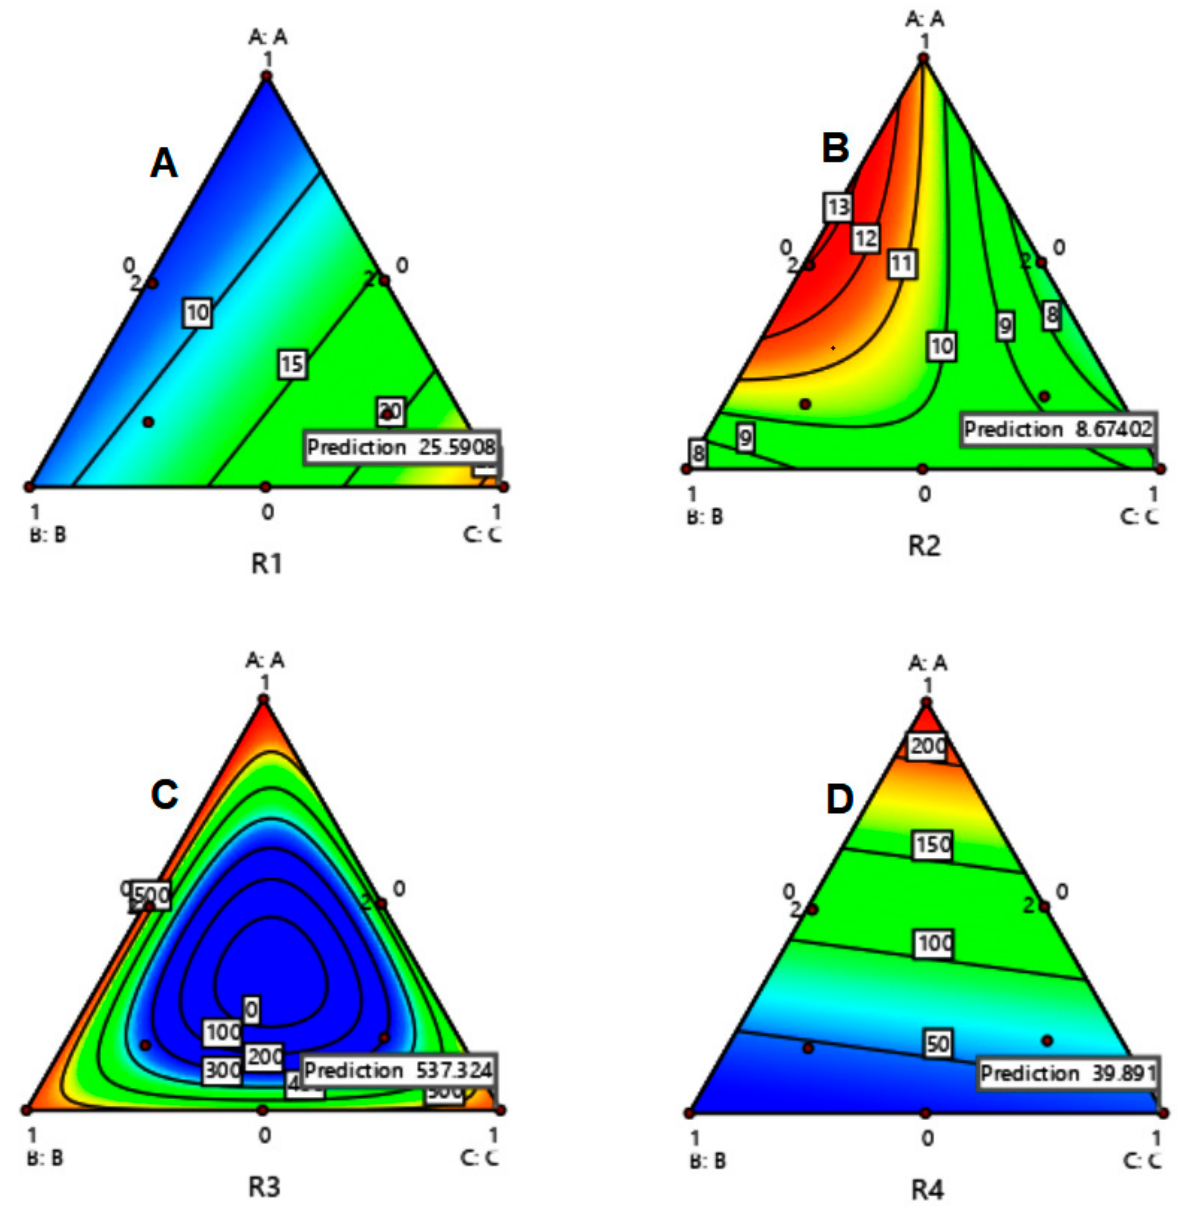
Figure 4. RSM of MCC-starch-Mg silicate for a three-component mixture design with yield pressure ( P Y ) ( A ), P K ( B ), work of compression ( C ), and tablet hardness ( D ) as the responses. The ternary excipient (80% MCC, 30% starch, and 10% Mg silicate) at the contents of 10% formulated with 90% w / w metronidazole and paracetamol showed an